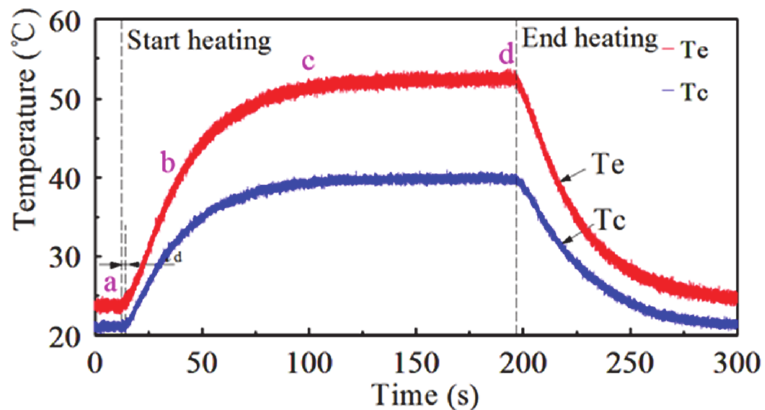
Figure 5. Temperature outside the evaporator and condenser section.